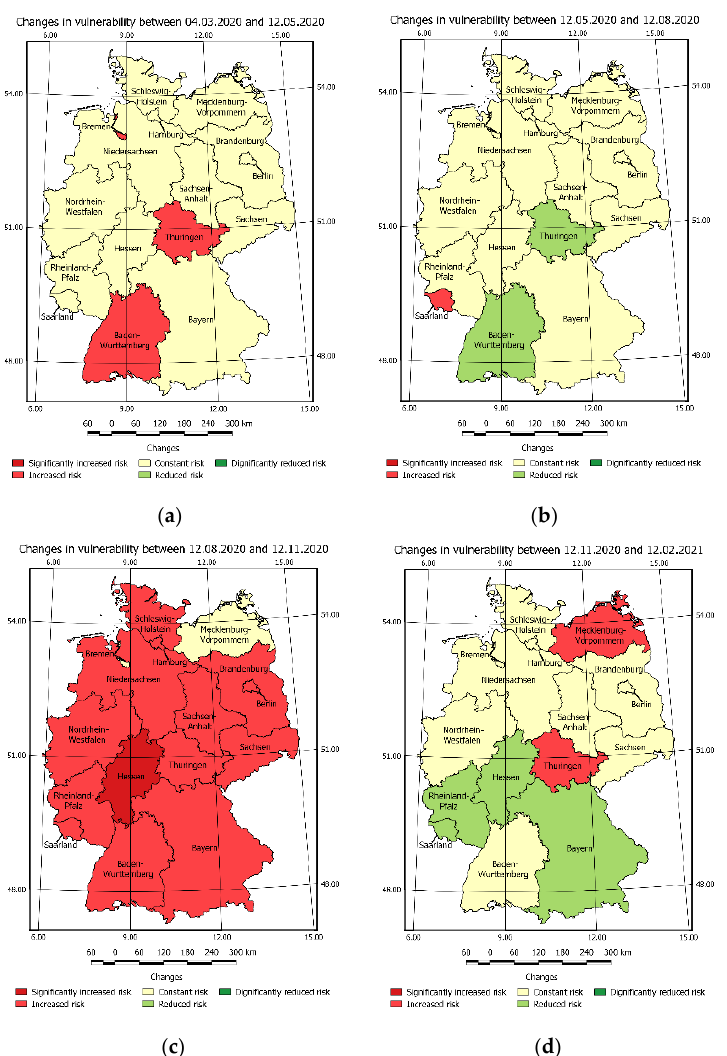
Figure 14. Vulnerability risk changes over time. ( a ) 04 March 2020 – 12 May 2020 ( b ) 12 May 2020 – 12 August 2020 ( c ) 12 August 2020 – 12 November 2020 ( d ) 12 November 2020 – 12 February 2021 re- maining maps are available in Figure A4.